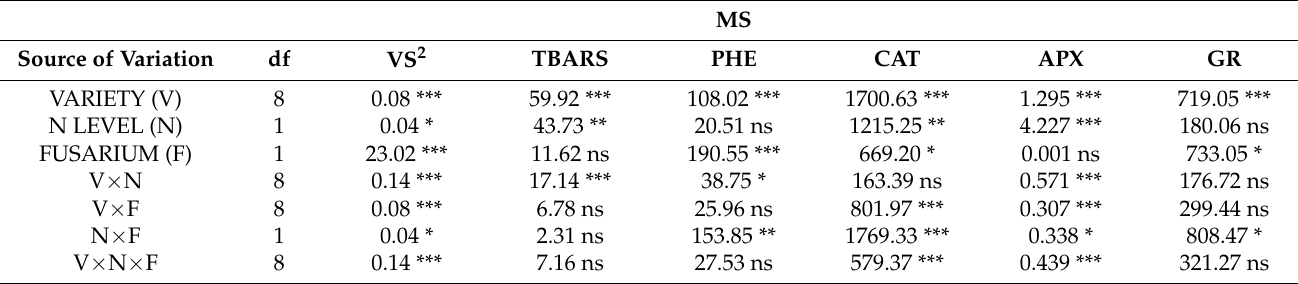
Table 1. Three-way ANOVA for visual scoring and five different biochemical parameters under different nitrogen and Fusarium treatments in spikes of nine winter wheat